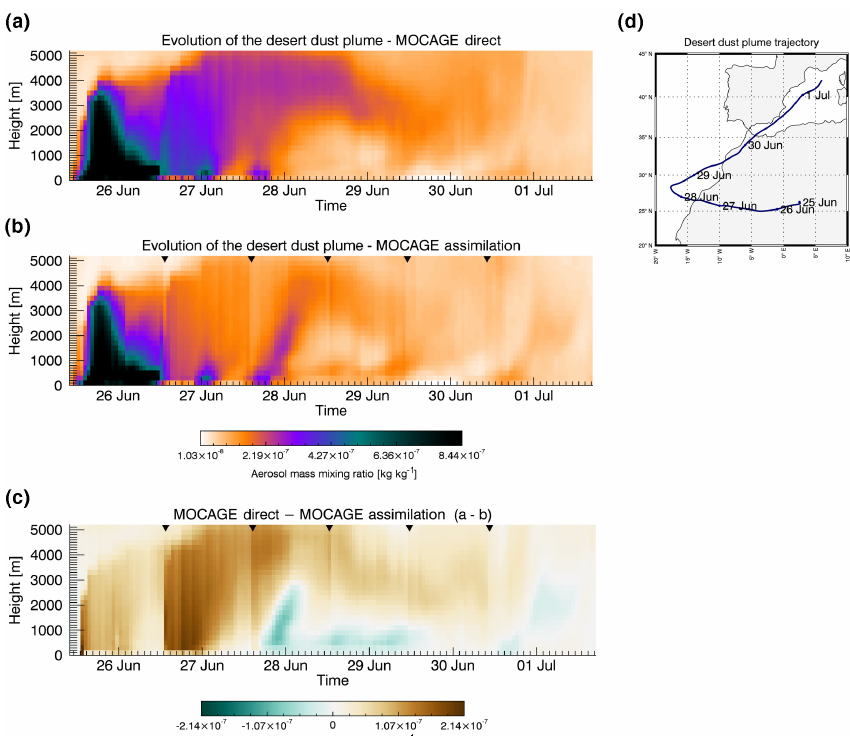
Figure 10. The evolution of the aerosol vertical profile over the course of 1 week from 25 June to 2 July 2012 in the direct model run (a) and the assimilation model run (b) and the difference between the direct and the assimilated model run (c) . The units are in mass mixing ratios, with the values represented by colours identified in colour bars. In (b) the passes of the MODIS over the plume are marked by the triangles. The desert dust plume is followed from its sources in Africa to its weakening and dissolution in the Mediterranean Sea (d)